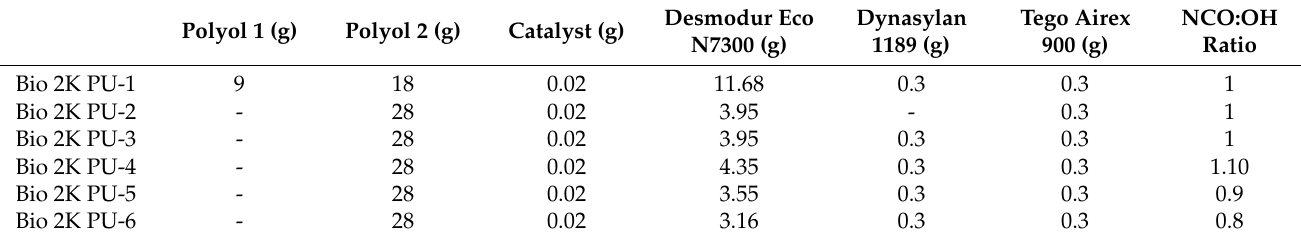
Figure 1. Schematic flow of the 2K PU coating on polyester fabric involving the preparation of coating formulation, application of the formulation via the knife-over-roll method and curing in an oven for 2 min at 155 ◦ C to obtain the coated fabric. Table 1. Composition of the bio-based 2K PU coatings and molar equivalent NCO:OH